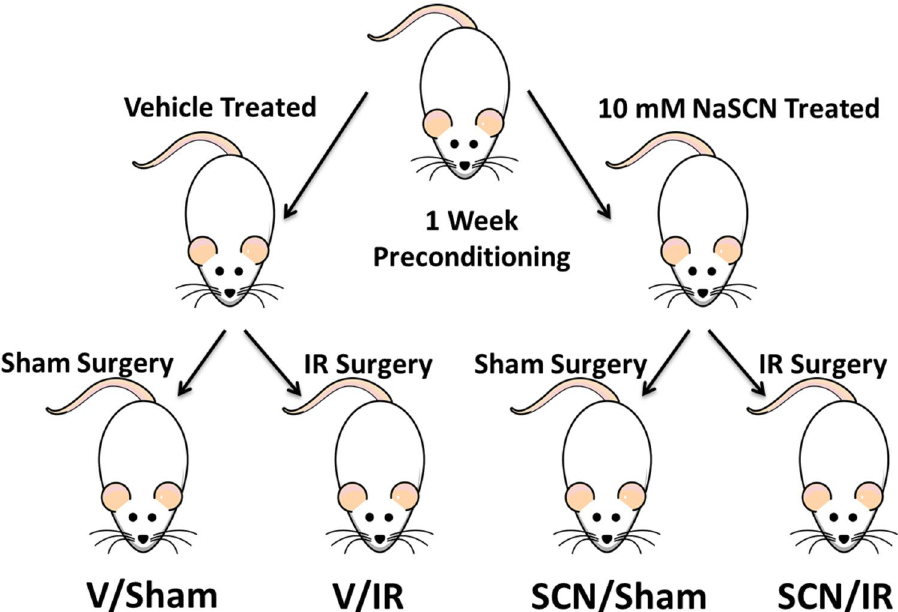
Figure 1. Rat IR experimental model. Sprague–Dawley rats were preconditioned for one week with either regular water or 10 mM NaSCN before the start of the experiments. They then underwent either sham or IR surgery to give 4 groups; vehicle (V)-treated shams (V/Sham), V-treated IR (V/IR), SCN – treated shams (SCN/ Sham), and SCN – treated IR (SCN/IR). After sham or IR surgery the animals were allowed to recover for 24 h or 4 weeks before sacrifice and analysis.